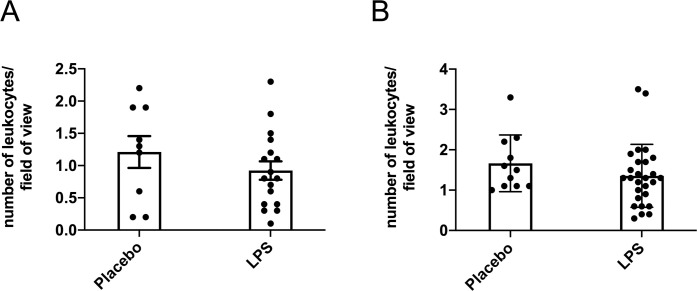
Blood smear leukocyte counts.Leukocytes counts were unchanged following 12-weeks of lipopolysaccharide (LPS) exposure in both (A) males (n = 9–17) (B) and females (n = 11–27). Ten fields of view per sample were analyzed, captured at 20x magnification.